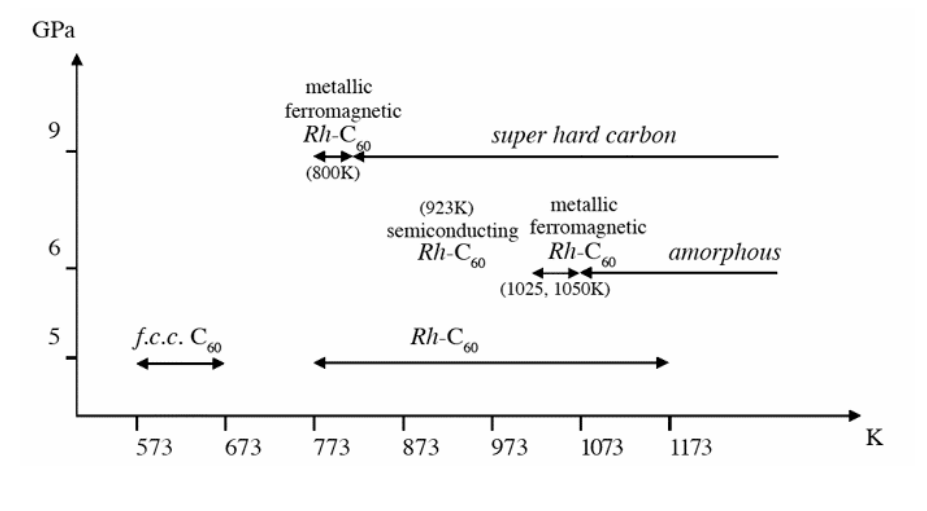
Figure 2. The summary of experimental results. Experimentally observed phases are